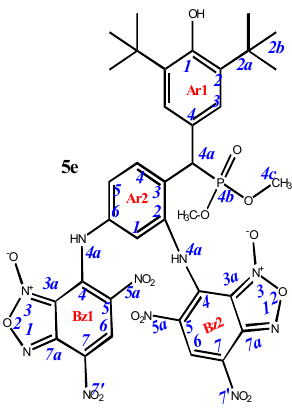
7,7’- (( 4- (( 3,5-di- tert -butyl-4-hydroxyphenyl )( dimethoxyphosphoryl ) methyl ) -1,3-p henylene ) bis ( azanediyl )) bis ( 4,6-dinitrobenzo[ c ][1,2,5]oxadiazole 1-oxide ) ( 5e ) . Red henylene ) bis ( azanediyl )) bis ( 4,6-dinitrobenzo[ c ][1,2,5]oxadiazole 1-oxide ) ( 5e ) . Red powder, yield 68%. M.p.: >250 ° С . IR ( ν , cm –1 ): 689 (P–C), 1212 (P=O), 1378 (NO 2 symm), powder, yield 68%. M.p.: >250 ° С . IR ( ν , cm –1 ): 689 (P–C), 1212 (P=O), 1378 (NO 2 symm), 1578 (NO 2 а symm), 1597 (C=C а rom), 1624 (furoxan ring) and 3449 (OH). 1 H NMR (400 1578 (NO 2 а symm), 1597 (C=C а rom), 1624 (furoxan ring) and 3449 (OH). 1 H NMR (400 MHz, DMSO- d 6 ) δ 9.00 (s, 1H, H6-Bz2), 8.91 (s, 1H, H6-Bz1), 7.32 (s, 2H, H3-Ar1), 7.18